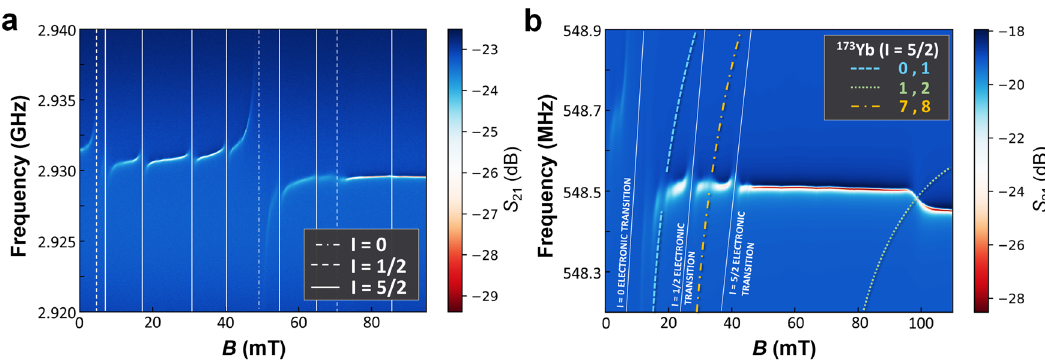
Fig. 2 Coupling cavity photons to multiple electronuclear spin transitions in [Yb(trensal)]. a Color plot of the microwave transmission measured at T = 10 mK near the bare resonance frequency f r = 2.93 GHz of a LC superconducting resonator and as a function of the magnetic fi eld. Changes in the resonator mark the coupling of cavity photons to different electronic spin transitions. The crystal had a x = 5% Yb nominal concentration. The lines assign each of the observed features to the different Yb isotopes naturally present in this crystal b Same as in a for a f r = 548.5 MHz resonator and a crystal with x = 8%. This LC cavity is speci fi cally designed to optimally couple to nuclear spin transitions in [ 173 Yb(trensal)]. Some of them are identi fi ed in the caption. Color scale bars indicate the amplitude of the transmitted signal in relation to the input signal on a logarithmic